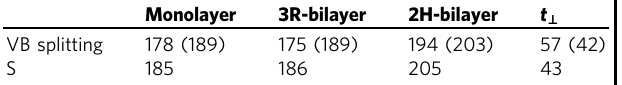
Values extracted for standard DFT calculations are in parentheses. All values are given in